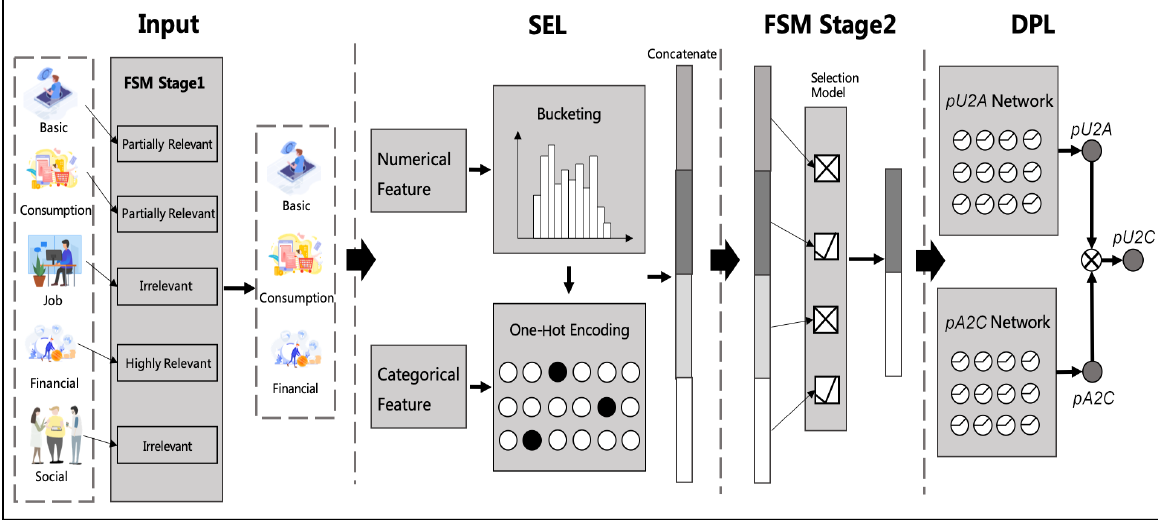
Fig. 3 Architecture overview of